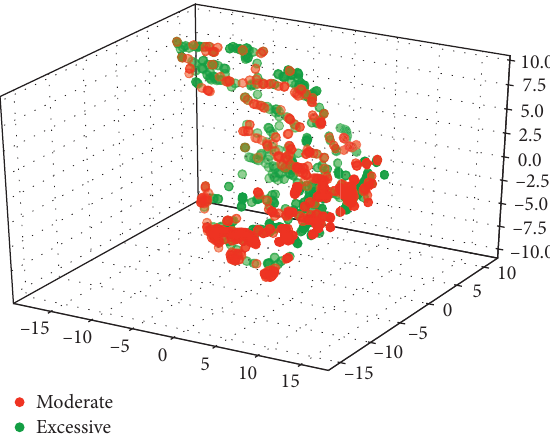
Figure 1: Visualization of the dataset in